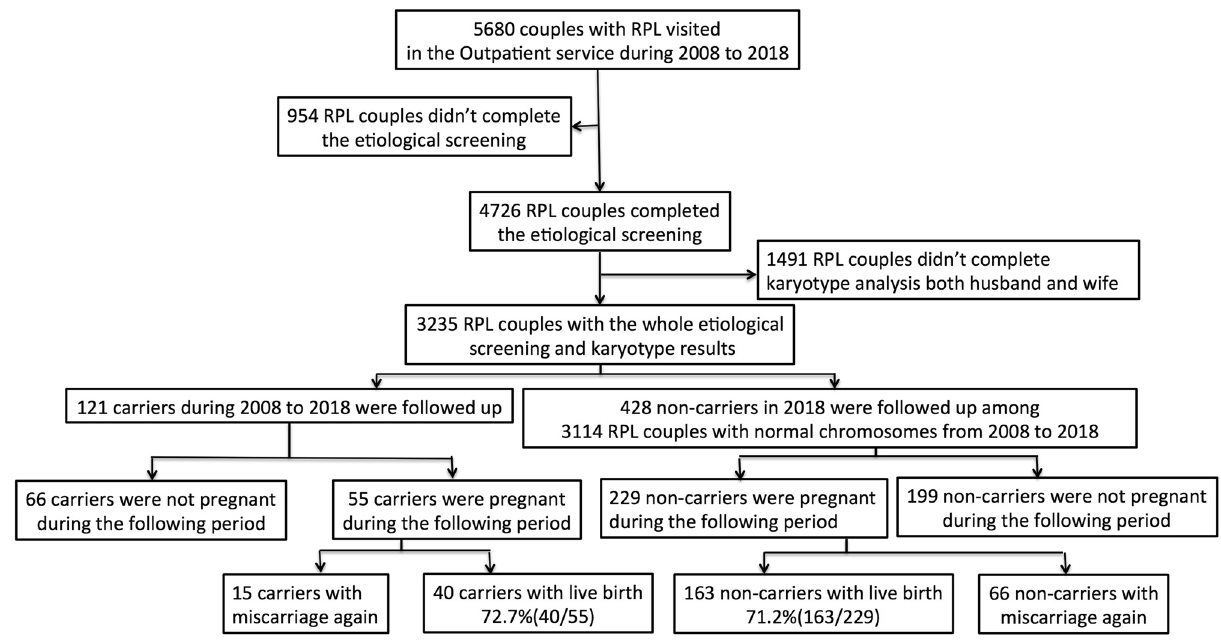
Figure 1. The flow chart presents the process of collecting abnormal chromosomal carriers from 5680 RPL couples in our Outpatient service.